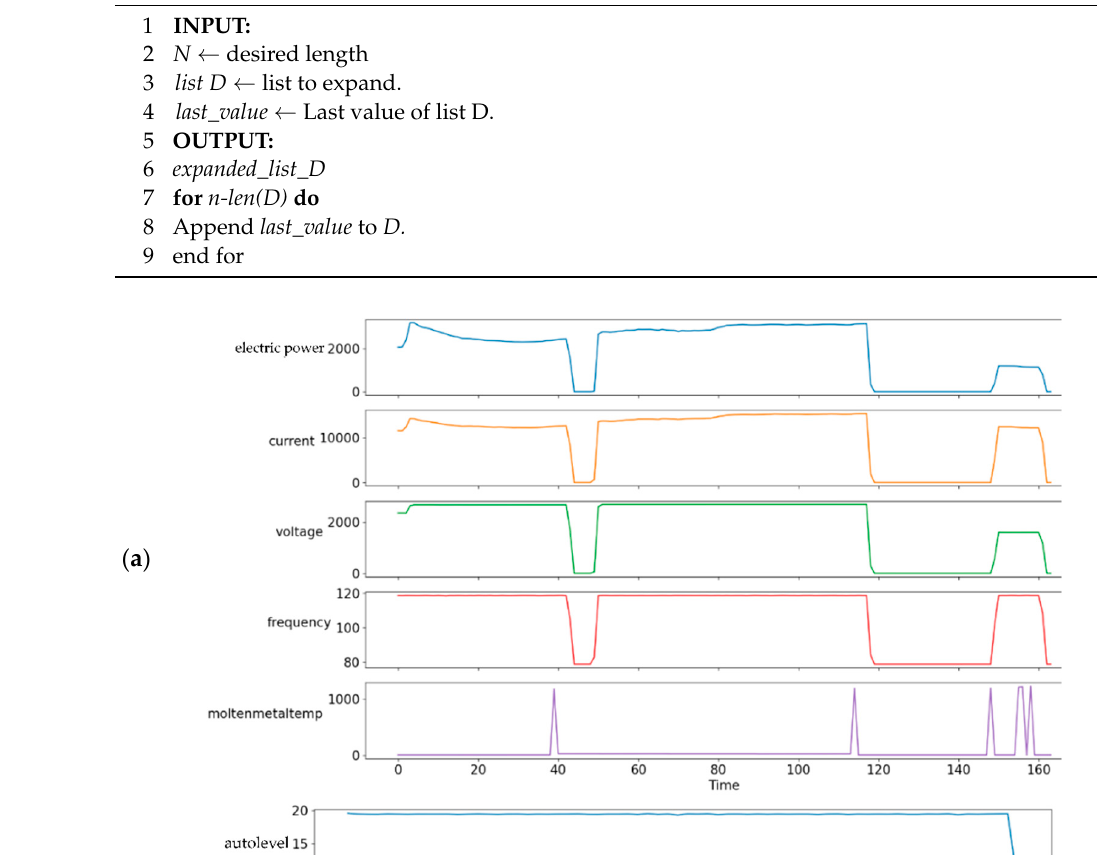
Algorithm 1. Expanding data into length n . Figure 8. Extracting melting and casting TSWP from real ‐ time data (pink areas indicate melting process, purple areas indicate casting process).